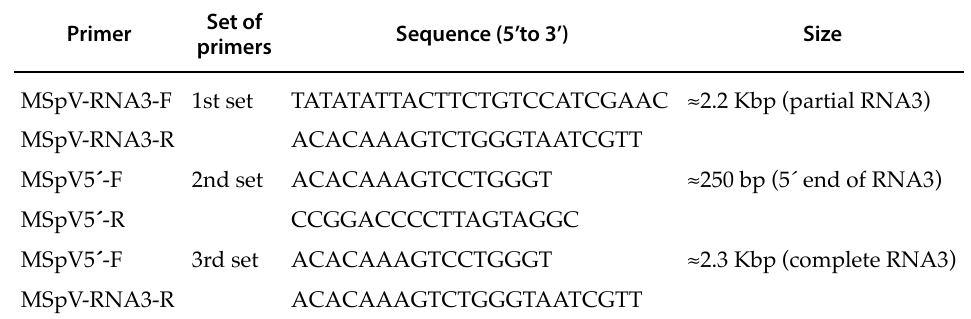
Table 1. Primers used for the amplification of RNA3 sequences of MSpV-Sorg isolates. Set of Primer primers